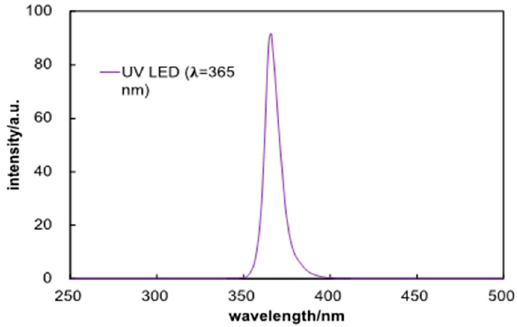
Figure 1. Photoemission spectra of UV-LED used in photocatalytic activity tests.